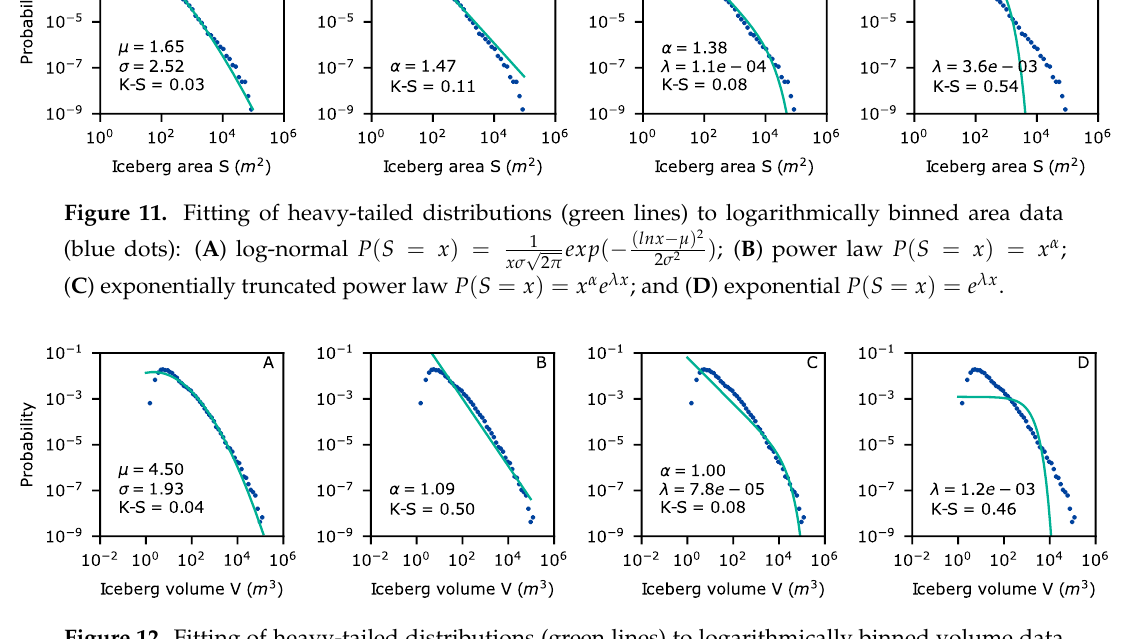
2 ) ; ( B ) power law P ( V = x ) = x α ; √ exp ( − ( lnx − µ ) 2 σ 2 x σ 2 π